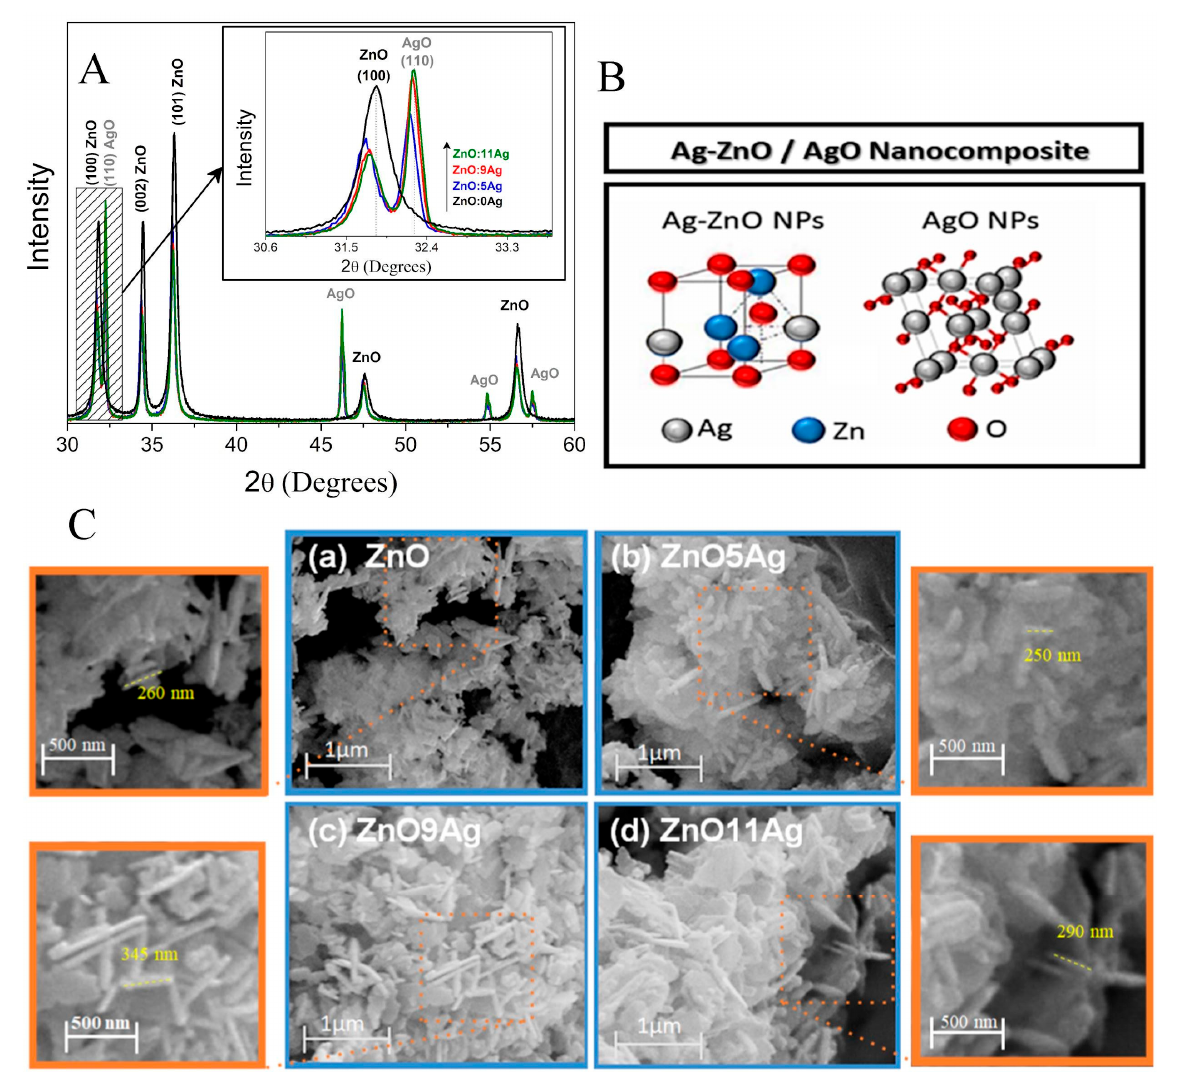
Figure 1. Characterization of Ag-ZnO/AgO Nanocomposites. ( A ) X-ray patterns of ZnO nanocrys- and Ag-ZnO/AgO Nanocomposites (ZnO:5Ag, ZnO:9Ag and ZnO:11Ag). Inset shows the alterations of the ZnO and AgO main peaks due to the Ag concentration. ( B ) Representation of nanocomposite formed by Ag-doped ZnO nanocrystals and AgO nanocrystals. ( C ) Scanning microscopy images of ZnO nanocrystals and Ag-ZnO/AgO Nanocomposites (a) ZnO (b) ZnO:5Ag (c) ZnO:9Ag and (d) ZnO:11Ag and a magnification was performed to visualize the dimensions of the